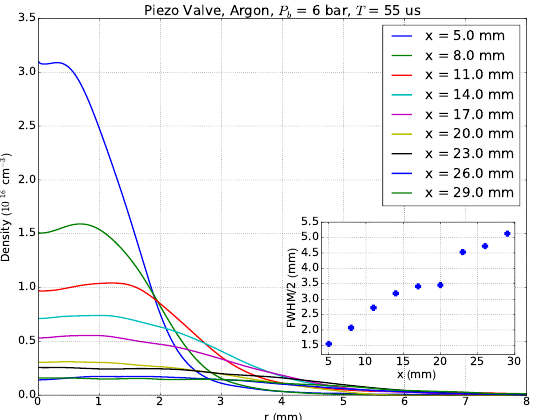
Figure 13. Density measurements of the piezo valve used for SwissFEL instrumentation. The reconstruction is computed via an Abel inversion. The subplot indicates the FWHM of the gas density distribution as a function of the distance from the throat.